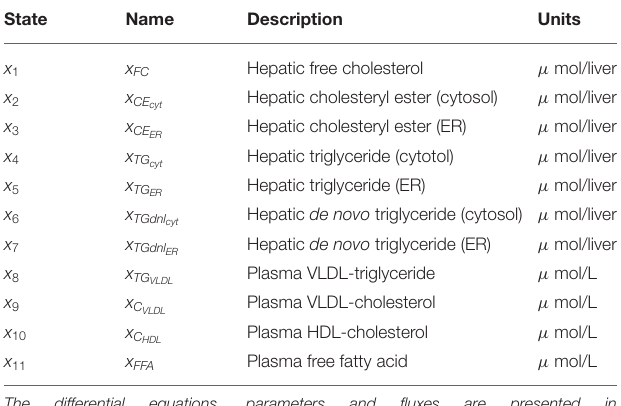
TABLE 1 | State variables included in the HepaLip2 model ( Figure 1 ).